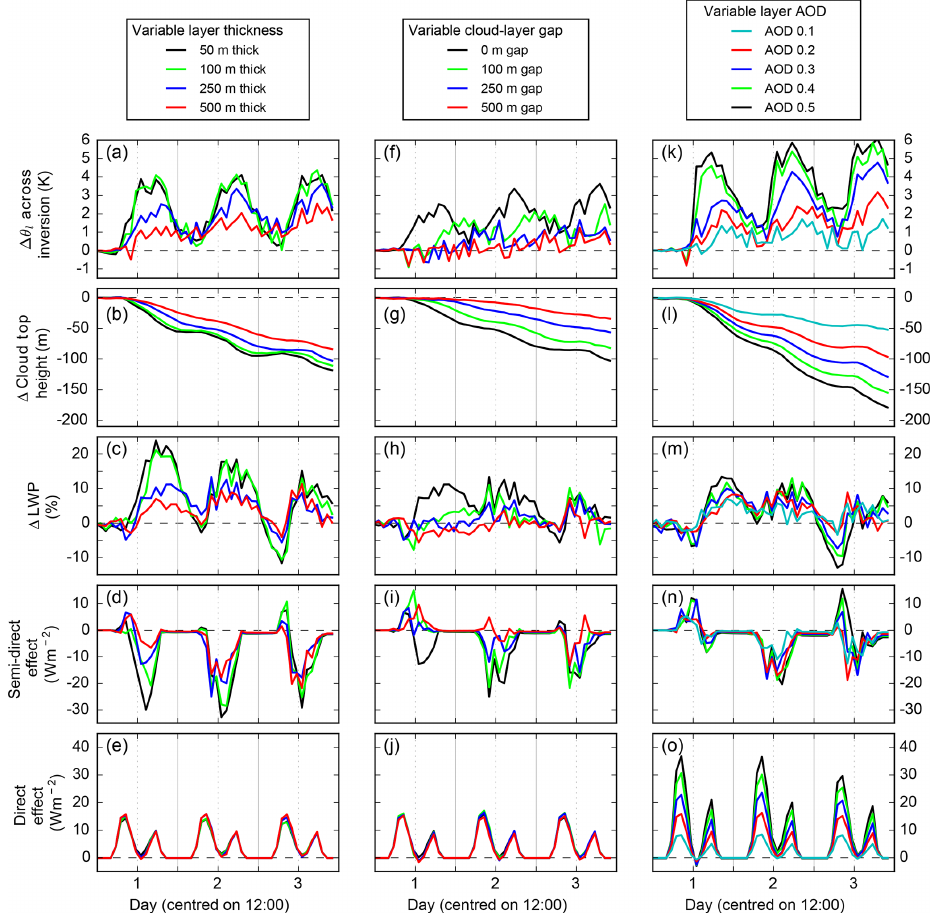
Figure 7. 3d time series showing the sensitivity of the initial cloud response (difference between the no-aerosol simulation and the simulation with an elevated aerosol layer) to the properties of the elevated absorbing aerosol layer. The three columns correspond to experiments in which systematic changes have been made to the aerosol layer thickness (a–e) , cloud–aerosol gap (f–j) , and aerosol layer AOD (k–o)